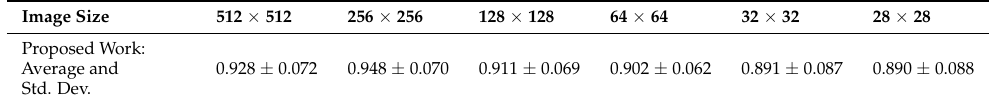
Table A1. Additional average and standard deviation based on training image resolution.